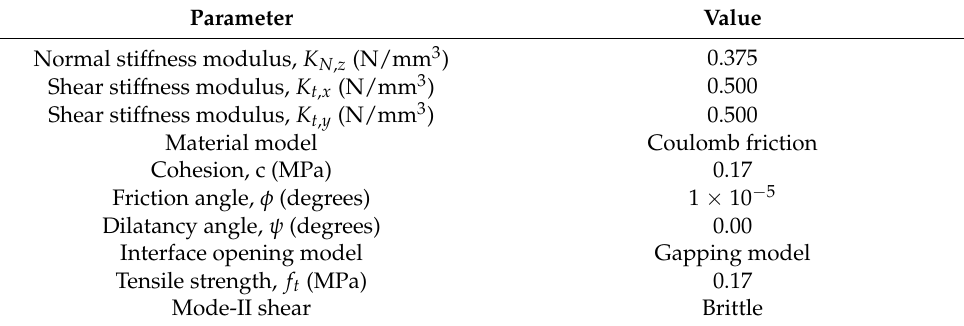
Table 4. Interface